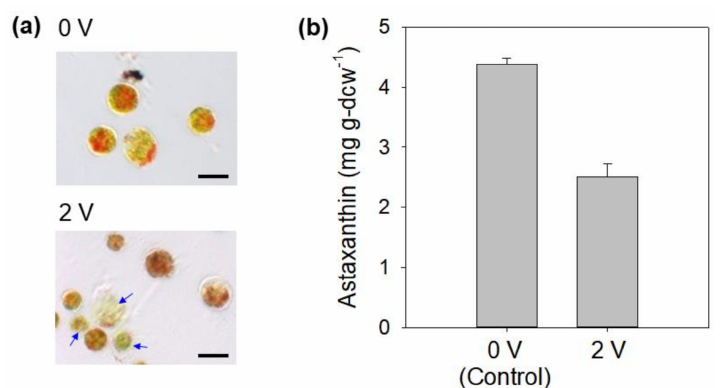
Figure 3. Microscopic image ( a ) and astaxanthin content ( b ) in Haematococcus pluvialis cells after electro-treatment at 2 V (current: 3 mA) for 2 days in the cathodic chamber of the two-chamber electrochemical reactor. The blue arrows in Figure 3a represent cells damaged or disrupted by electric stress. Scale bars in the optical images represent 50 µ m.